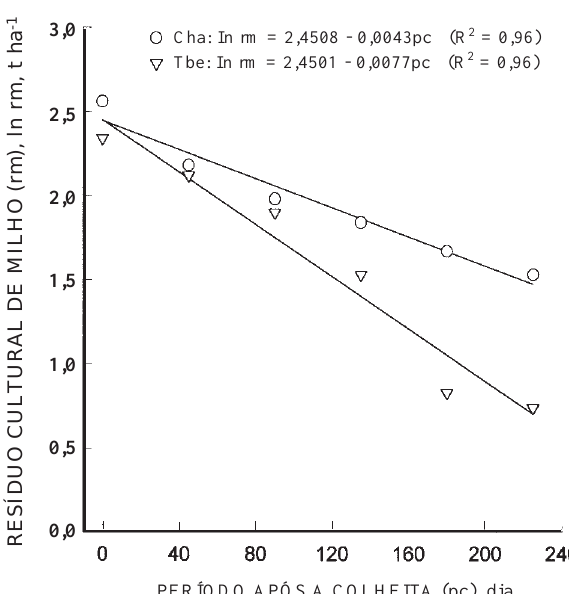
Figura 4. Persistência do resíduo cultural de milho (rm), sobre a superfície do solo na semeadura direta, no Cambissolo Húmico álico de Lages (Cha), e na Terra Bruna estruturada de Lebon Régis (Tbe), no período de 225 após a colheita manual da cultura (pc), de maio a dezembro de 1996.